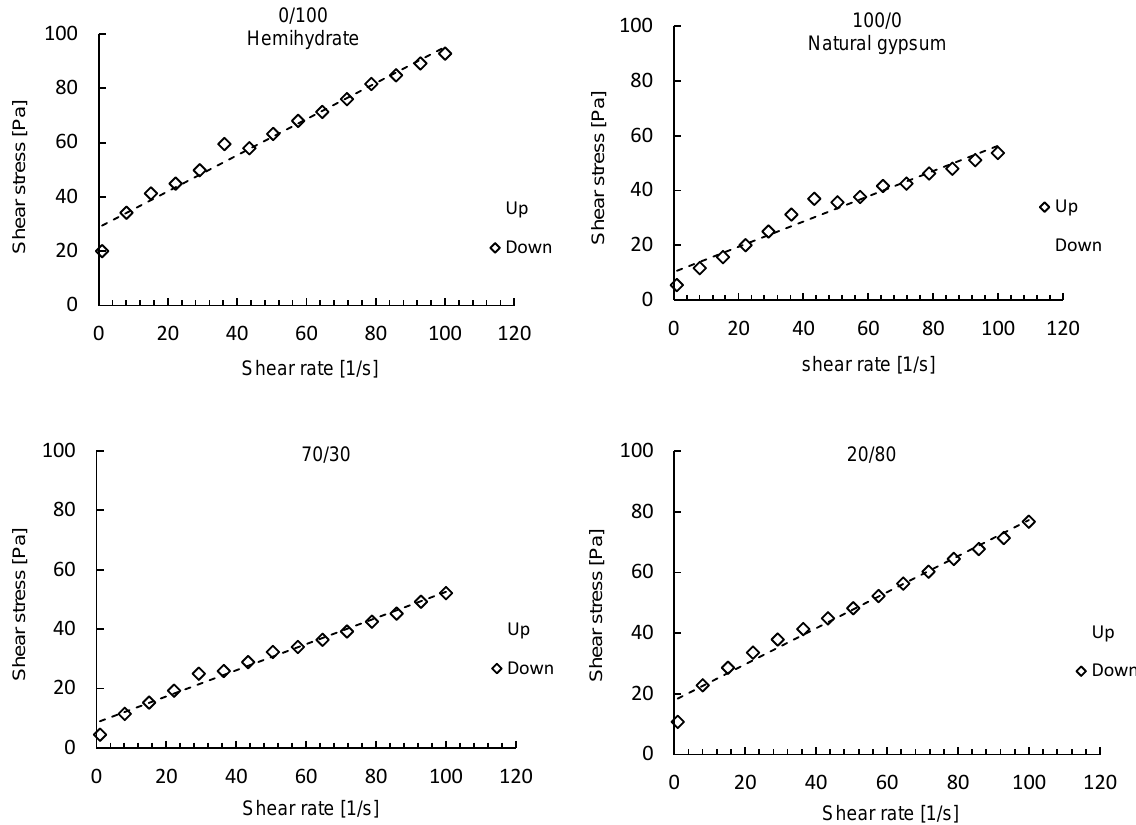
Figure 1: Typical flow curves of cement pastes with different proportions of natural gypsum and hemihydrate within gypsum cement phase.